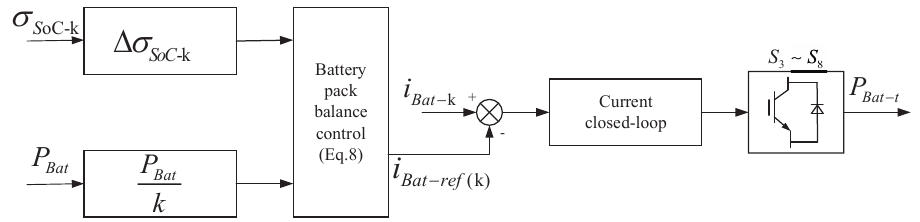
Figure 4. The balance control diagram of the battery